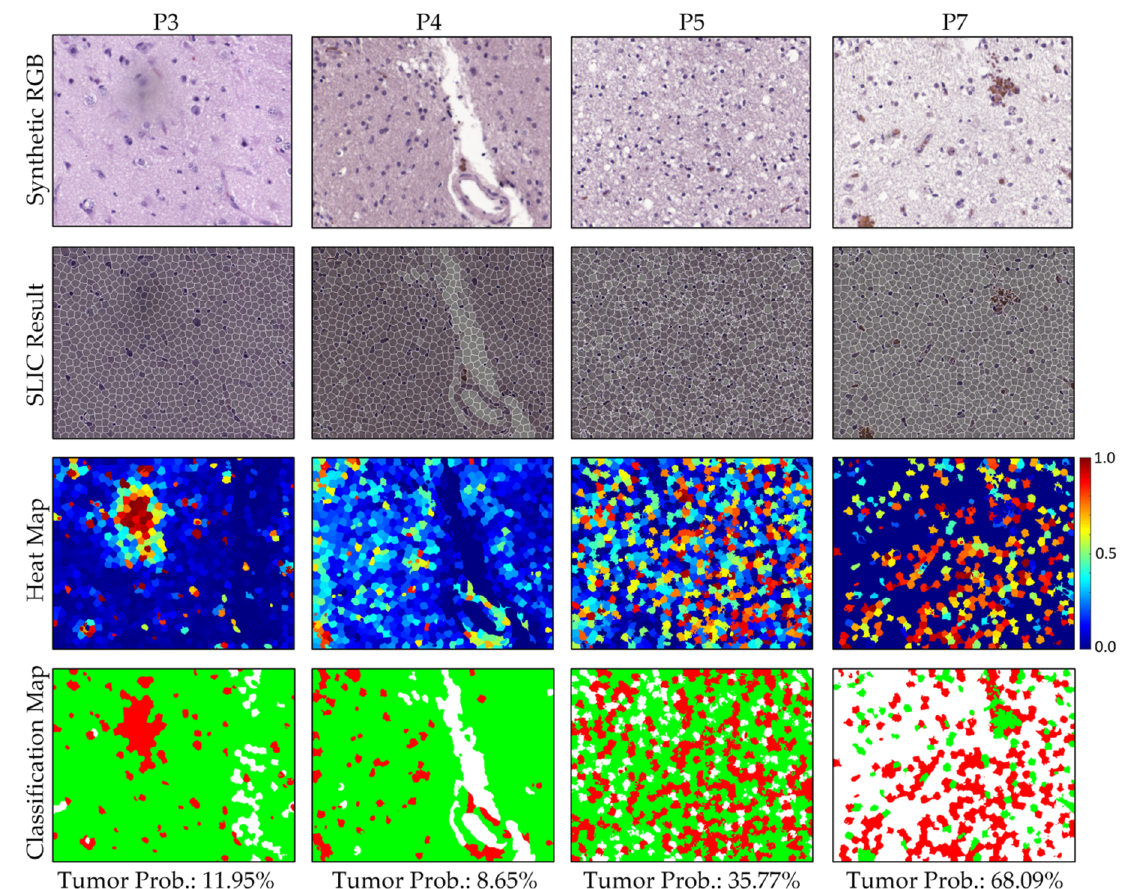
Figure 15. Heat and classification maps of four example non-tumor images. First row shows the synthetic RGB image of the HS cube, while second row represents the SLIC result. Third row represents the heat map, where red colors represent higher tumor probability. Fourth row shows the classification map, where red, green and white colors indicate tumor, non-tumor and light superpixels, respectively. In the last row, the tumor presence probability of the image is indicated. HS images with classification results with tumor probability >= 50% were considered tumor images, while results < 50% were considered non-tumor images.